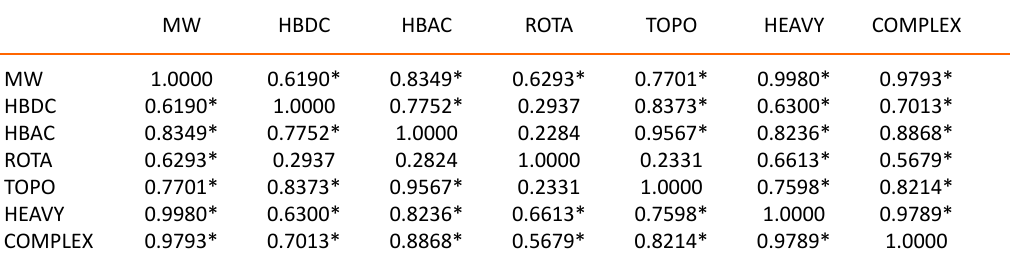
Table 3. Correlation between the physicochemical properties of the antiviral drugs MW HBDC HBAC ROTA TOPO HEAVY